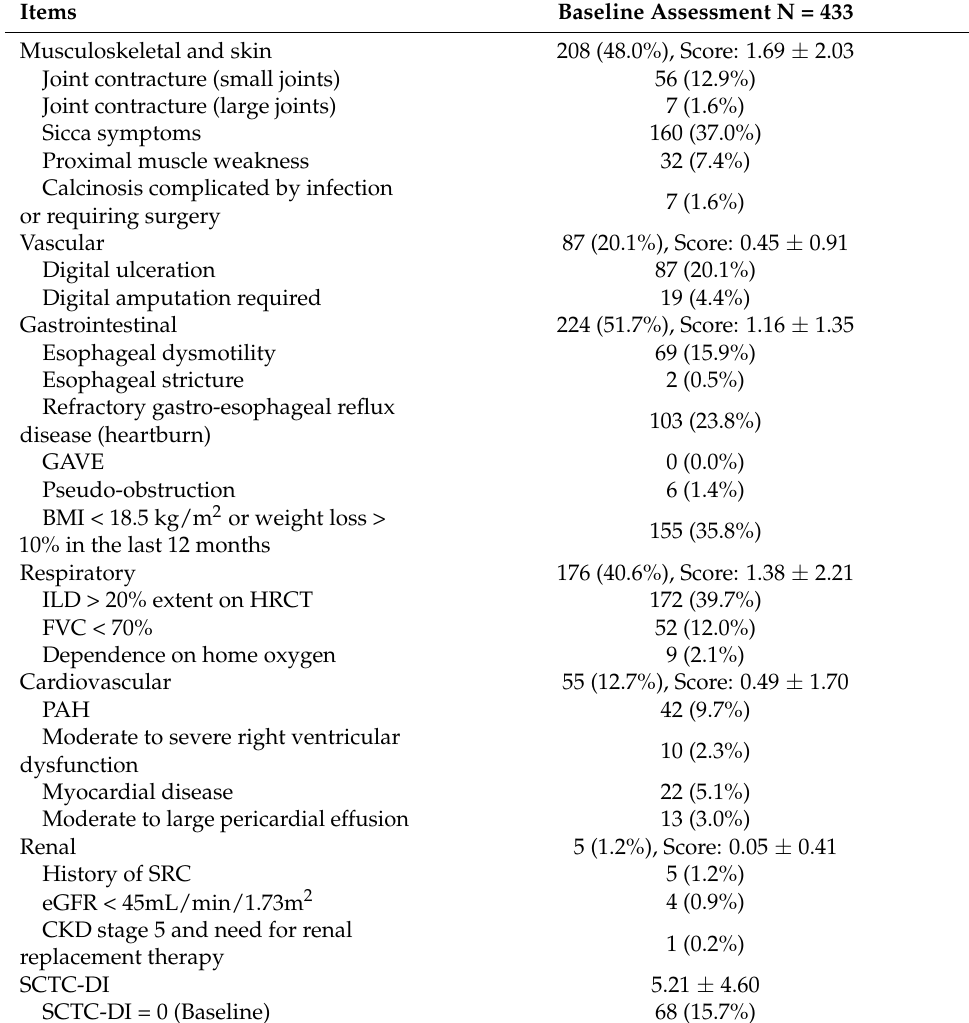
Table 2. Frequency of SCTC-DI items in SSc